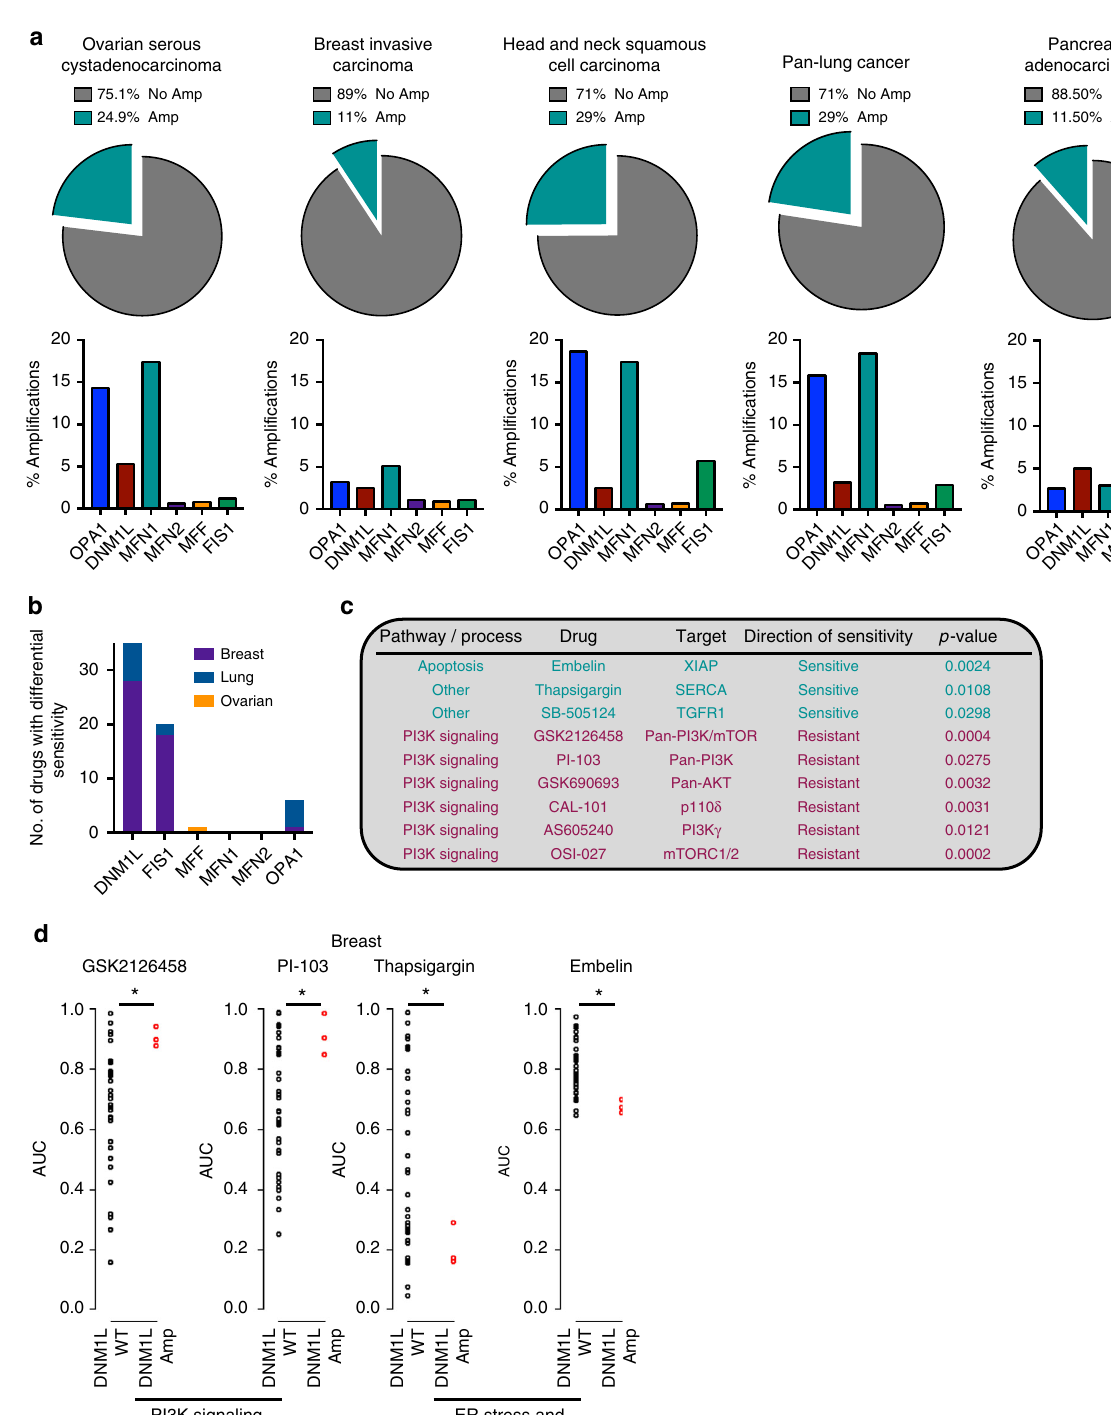
Fig. 1 Computational proof-of-principle that cancers with altered mitochondrial dynamics exhibit differential drug sensitivity. a Top, pie charts in fi ve major cancer types summarizing the percentage of tumors with ampli fi cations in DNM1L , OPA1 , MFF , MFN1 , MFN2 , or FIS1 , using publicly available data from the TCGA. Bottom, bar graphs summarizing the percentage of ampli fi cations in each of the six genes from above. b The number of drugs from a dataset of 265 drugs with statistically signi fi cant differences in sensitivity when cell lines of a given cancer type are strati fi ed based upon ampli fi cation status of each of the six genes listed above making sure to control for ampli fi cations in neighboring oncogenes. c Examples of the drug sensitivity differences from b in DNM1L ampli fi ed breast cancer. d Four drugs from c are shown to illustrate the differences in drug sensitivity between DNM1L -ampli fi ed breast cancer vs. wild-type breast cancer. * p < 0.05 by Welch ’ s t -test. AUC area under the curve for the drug sensitivity